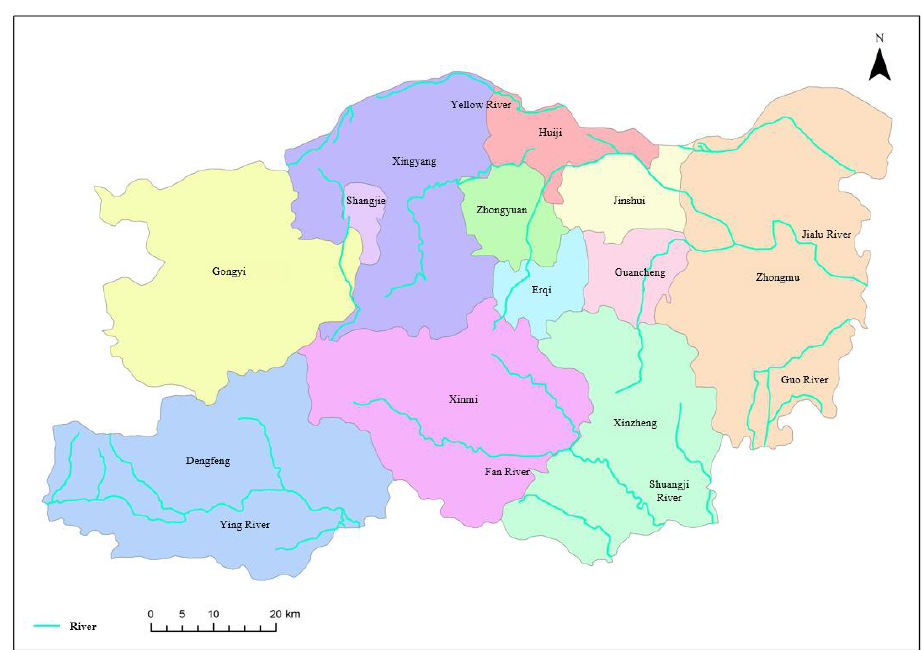
Figure 1. Administrative division of Zhengzhou city.